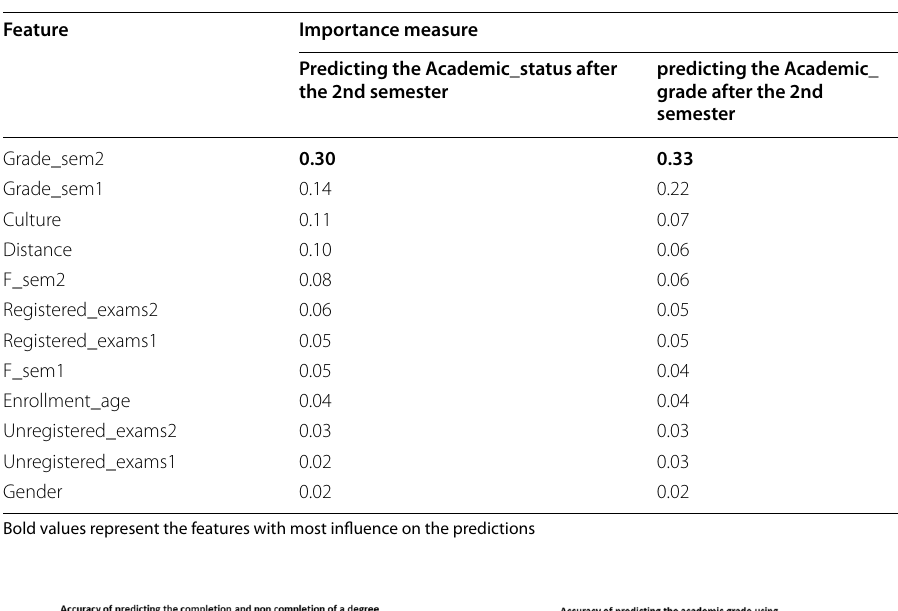
Bold values represent the features with most influence on the predictions Table 8 Features level of importance on the predictions performed after the 2nd semester